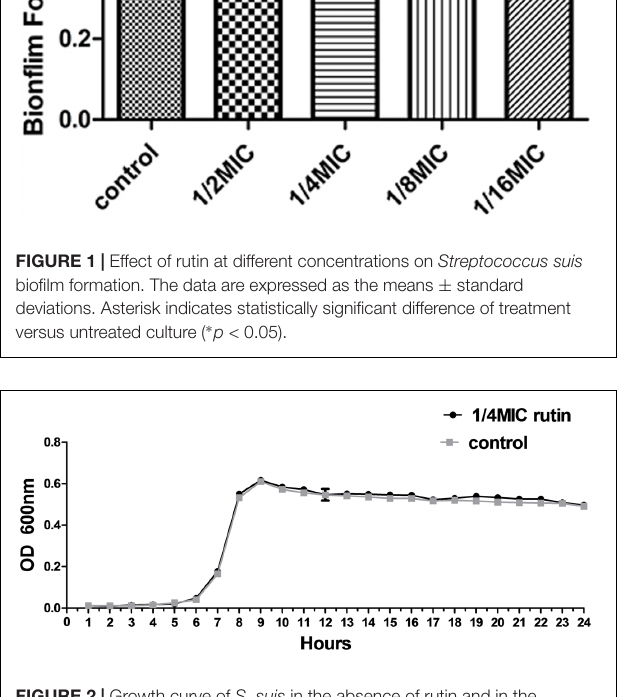
FIGURE 2 | Growth curve of S. suis in the absence of rutin and in the presence of rutin at 1/4 MIC (0.0781 mg/ml). The data are expressed as the mean ± standard